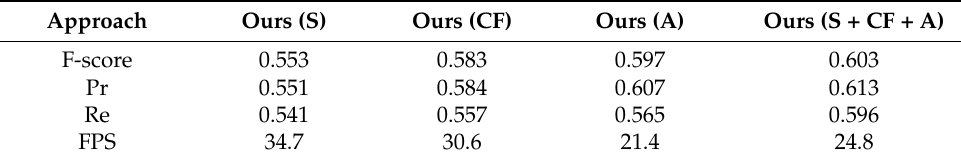
Table 7. Contribution of different modules for the proposed approach.